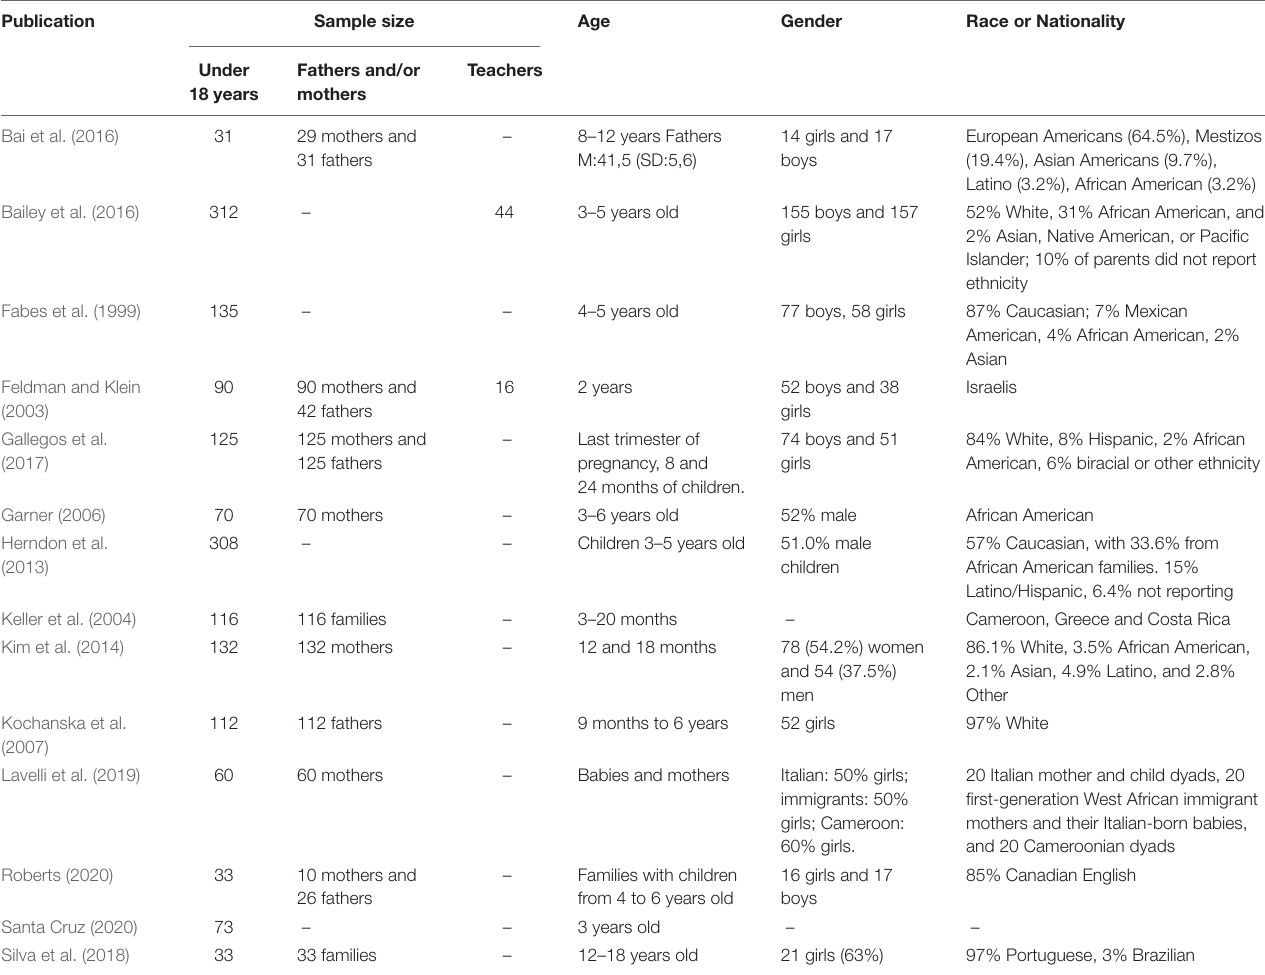
TABLE 2 | Substantive